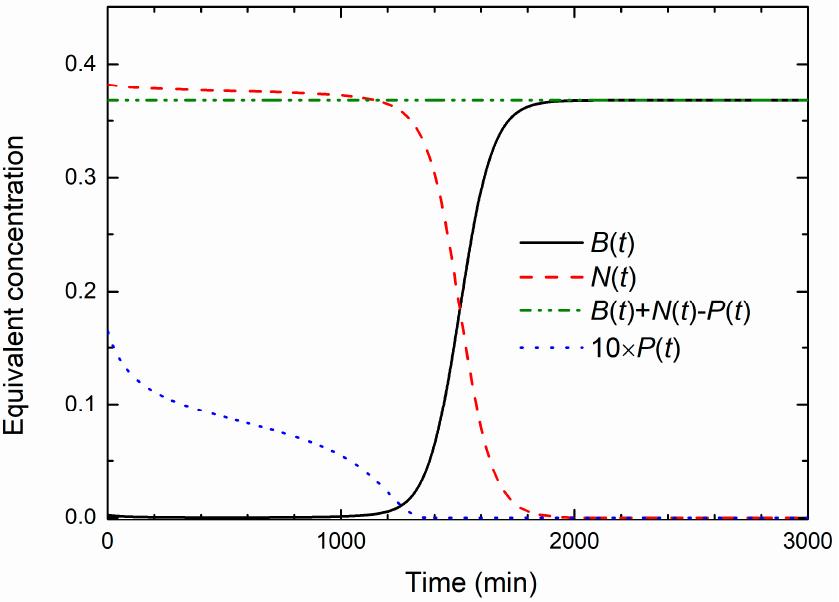
Figure 4. Time change of bacterial concentration B ( t ) and the equivalent concentrations of nutrients N ( t ) and nanoparticles P ( t ) as obtained from the solution of Equations (1)–(3). Note the conservation of the total growth capacity B ( t ) + N ( t ) − P ( t ) = const .